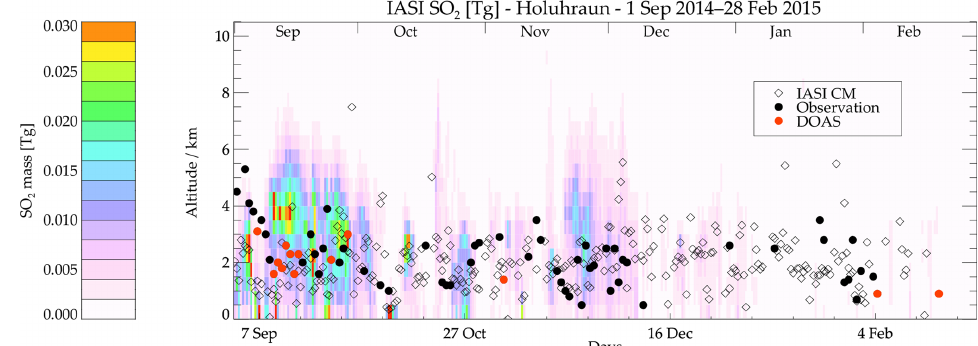
Figure 3. SO 2 vertical distribution in kilometres above sea level. The colours represents the mass of SO 2 and dark red represents values greater than 0.03Tg. Every column of the plot is generated from an IASI map (one every 12h; Fig. 1 and Supplement files). The black diamonds show the altitude of the centre of mass (CM) computed with the IASI pixels within 500km from the vent, and the red and black dots show the DOAS measurements and other observations from Pfeffer et al.